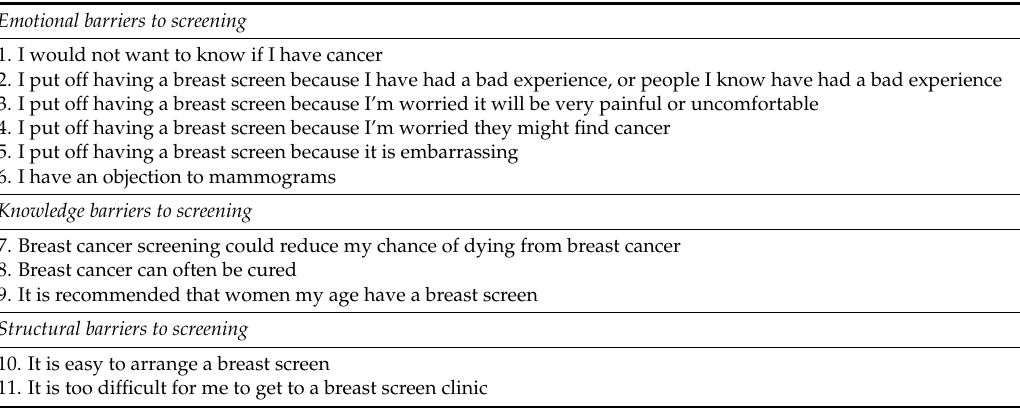
Table 2. Breast screening belief